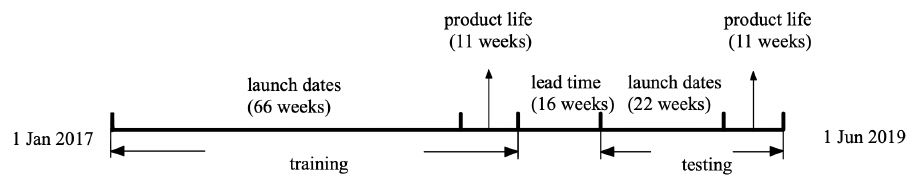
Figure 2. Partition of datasets into training and testing sets.